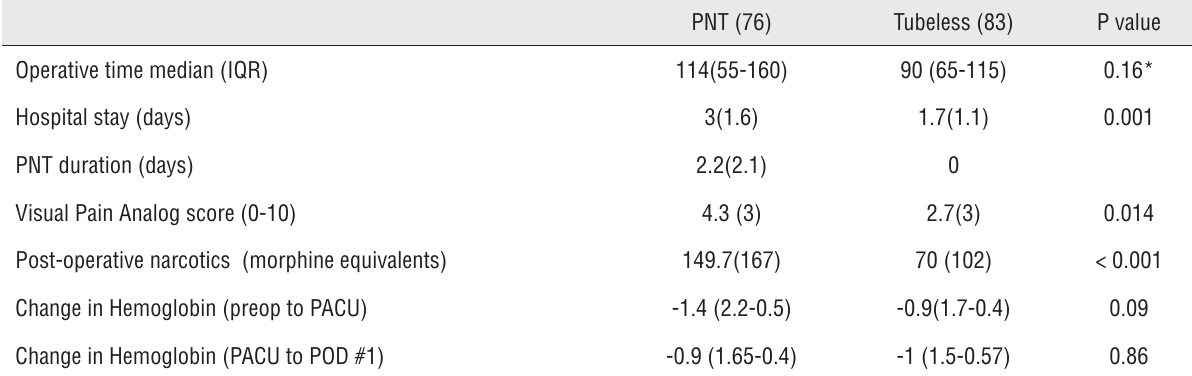
Table 2 - Peri-operative